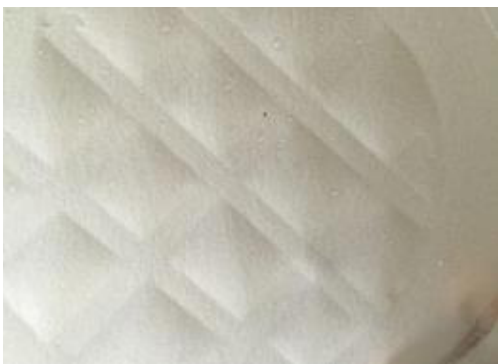
Figure A2. Brine conductivity and water recovery as functions of time for the system with tap water as feed.